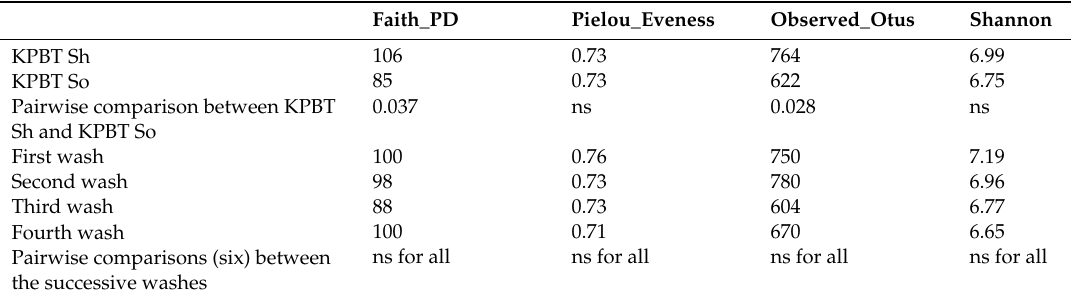
Table 4. Alpha diversity comparison (pairwise Kruskal-Wallis q -value) between the protocols, between successive washes before pooling of washes and after the pooling of washes of lettuce rhizoplane; ns = not statistically significant; pd= phylogenetic diversity; Sh = shaking; So = sonication. (a) Comparison of non-pooled washes (rarefied at 17,463 sequences); all the successive washes were pairwise compared